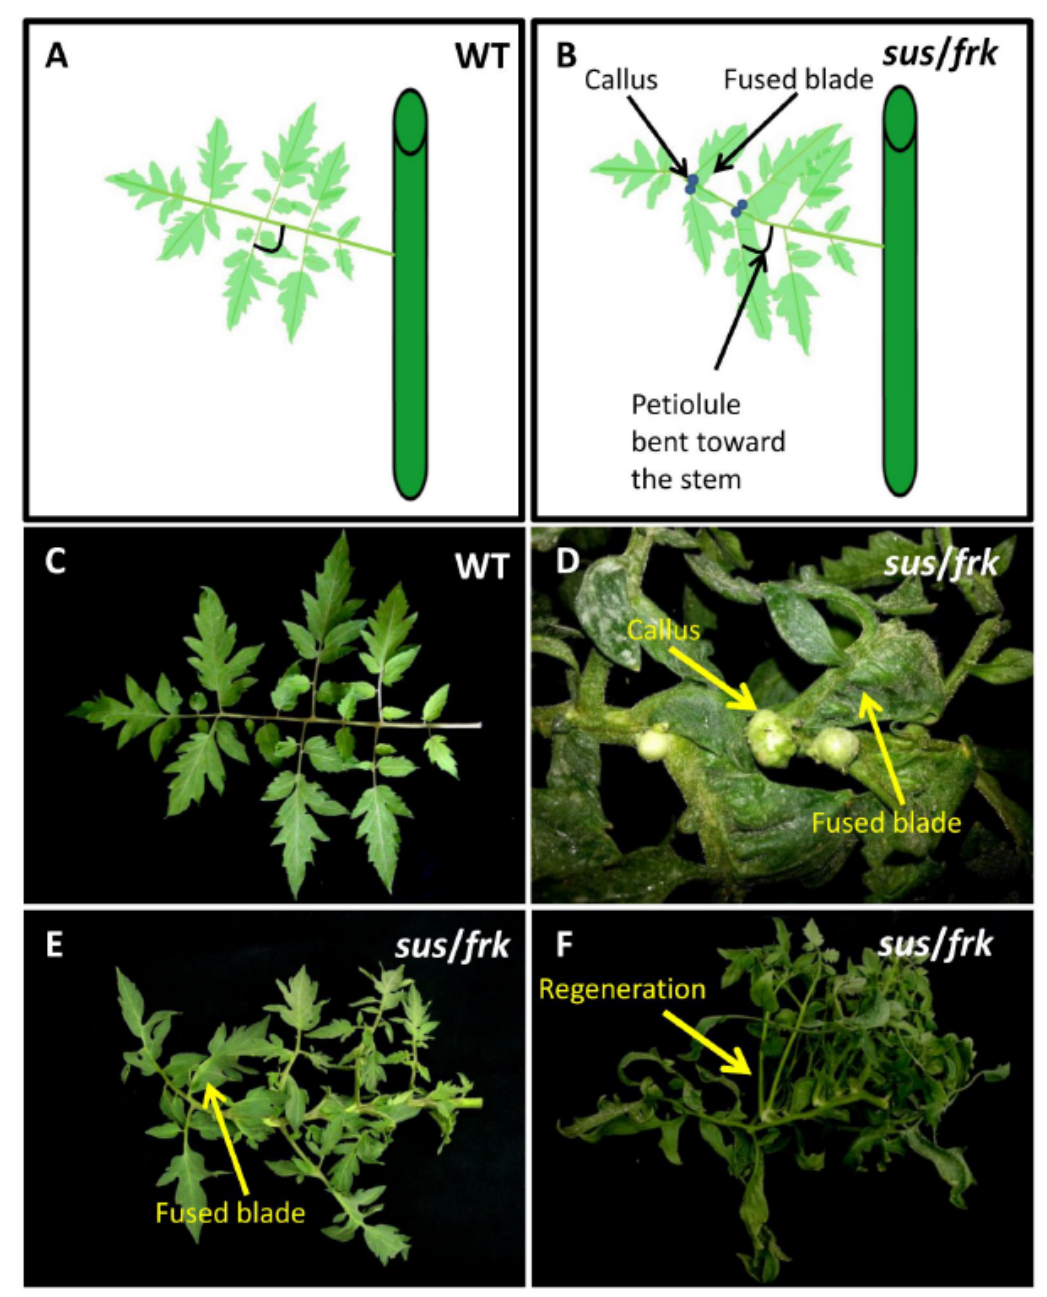
Figure 5. Morphological aberrations in sus/frk leaves. Schematic representations of ( A ) WT and ( B ) sus / frk leaves depicting the formation of callus tissue in the axil of the leaflet on the adaxial side of the leaf, the fused blade, and the petiolules bent toward the stem. ( C ) WT leaf. ( D ) A sus / frk leaf with a fused blade and callus (arrows). ( E ) A sus / frk leaf with a fused blade (arrow). Notice the bent petiolules. ( F ) In this sus / frk leaf, callus bulks transformed into shoot meristems and developed into new